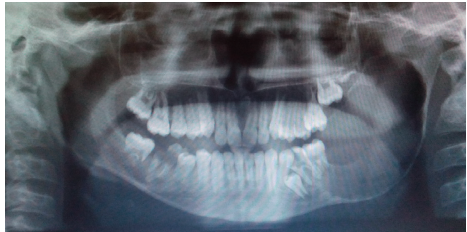
Figure 2: OPG showing large unilateral radiolucencies extending from the 1st permanent molar along the ascending ramus up to the neck of the condyle and involving coronoid process and thinning of the lower border and bowing of angle of mandible.